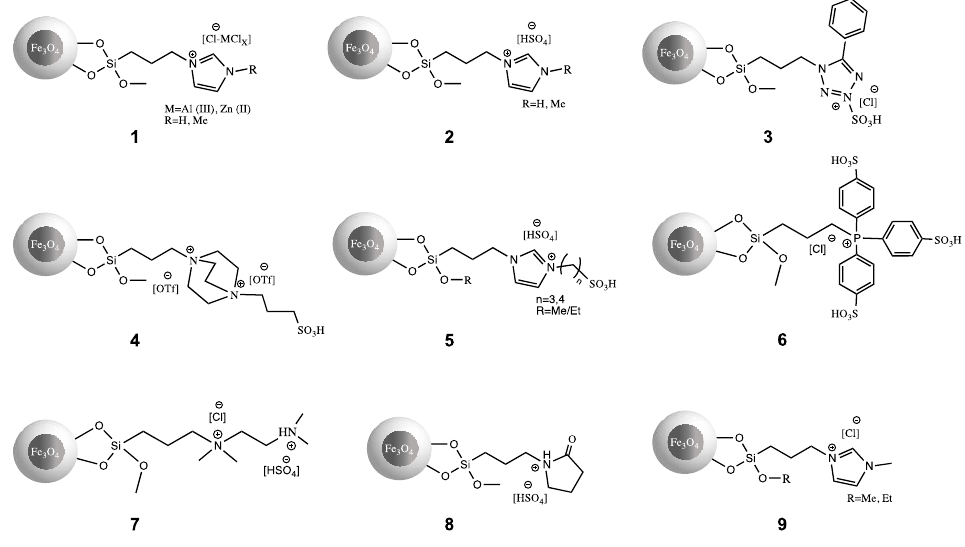
Figure 14. Structures of silica-Fe 3 O 4 -based SILLPs. Table 3. Silica-Fe 3 O 4 -based SILLPs in organic catalysis.